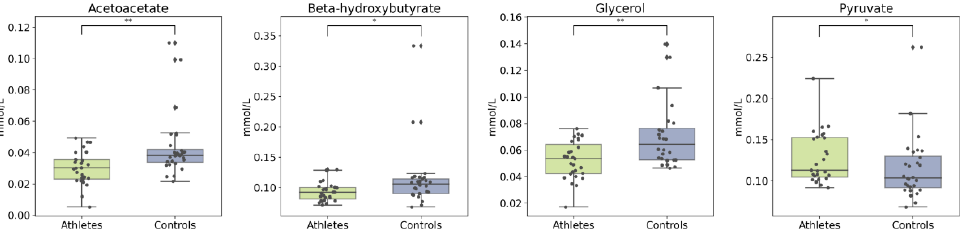
Figure 7. Boxplots of ketone bodies, glycerol, and pyruvate. Kruskal–Wallis p value: * < 0.05, ** < 0.01.